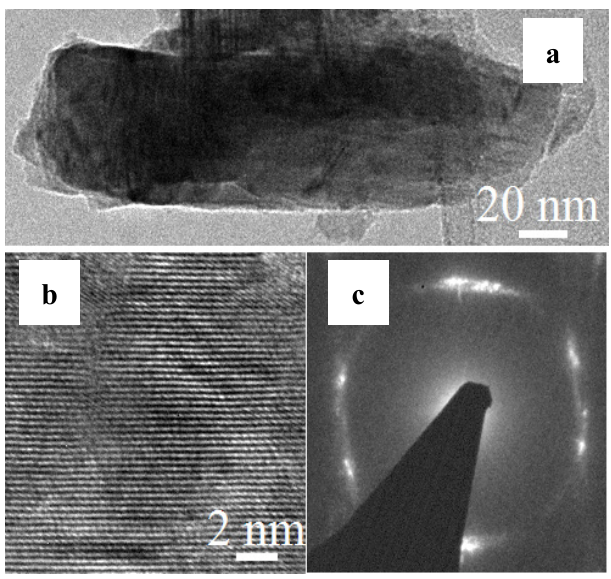
Figure 3. The transmission electron microscopy (TEM) study of ZnS nanoclusters: ( a ) TEM, ( b ) high resolution transmission electron microscopy (HRTEM), ( c ) selected area electron diffraction (SAED).